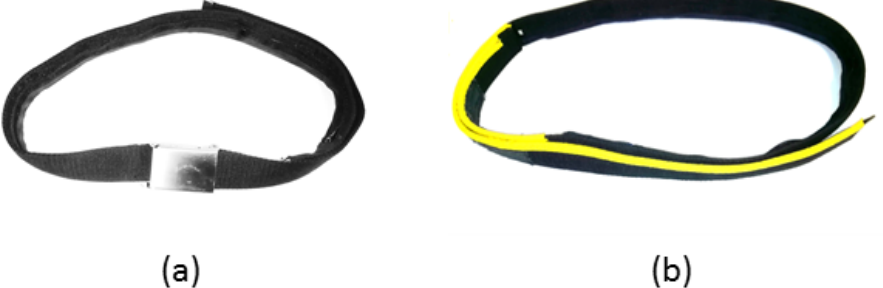
Figure 2. The applied sensor belt ( a ) in its original design and ( b ) in its adapted form.